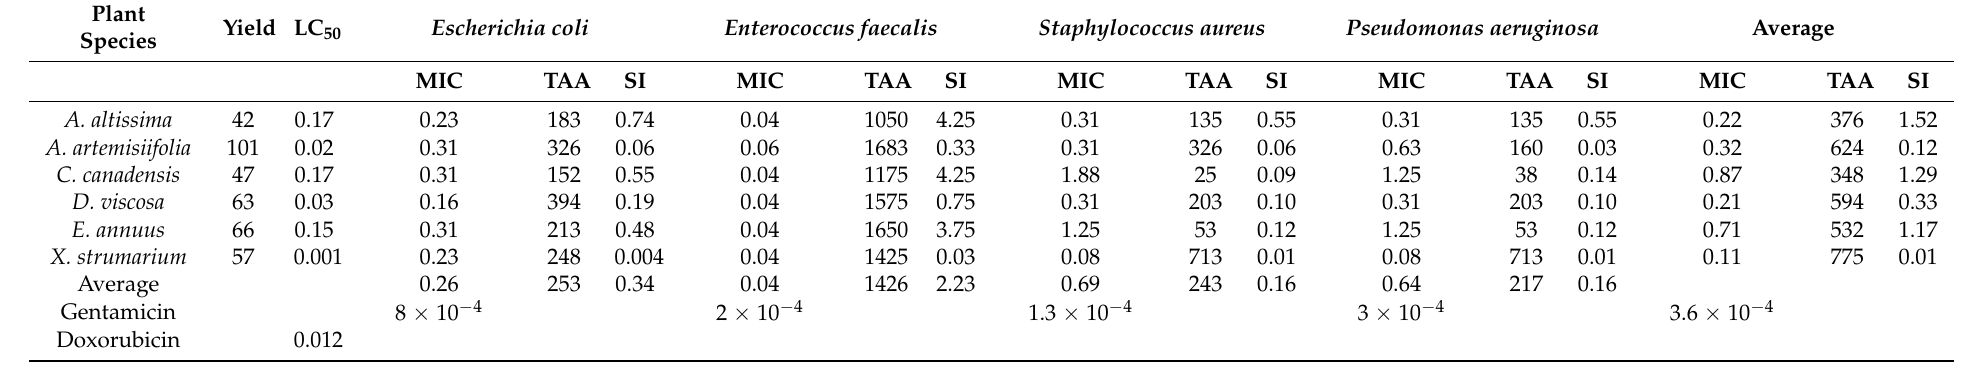
Table 2. Yield of extract (mg/g), cytotoxicity (LC 50 ) against Vero African green monkey kidney cells (mg/mL), minimum inhibitory concentration (MIC; mg/mL), total antibacterial activity (TAA; yield/MIC) after 24 h incubation (mL/g), and selectivity indices (SI; LC 50 /MIC) of the acetone extracts of different plant species and gentamicin (positive control) against test bacteria.